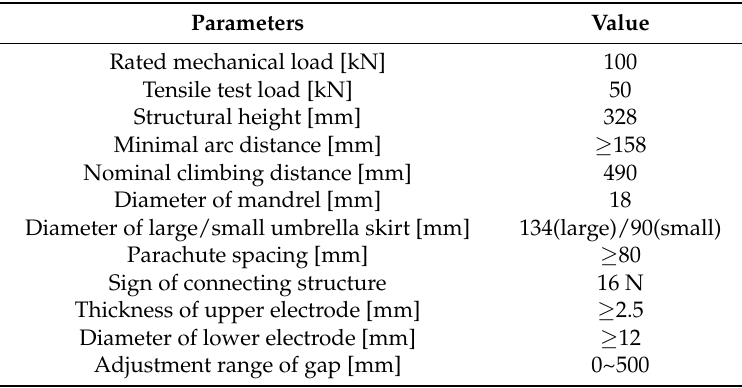
Table 1. Technical parameters of the ground wire